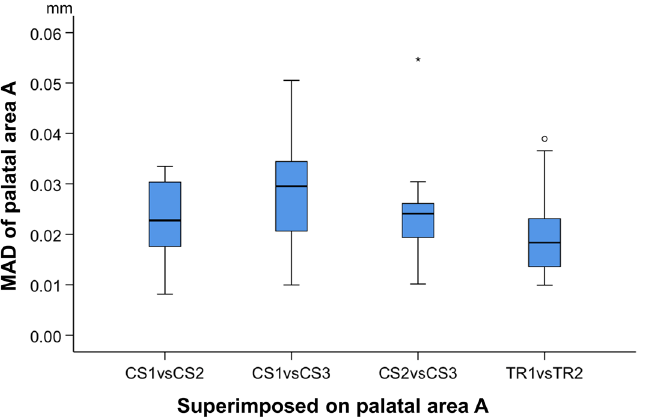
Figure 7. Box plots showing the precision of the two scanners (CS3600 and TRIOS3) measured through the MAD of palatal area A, between repeated scans superimposed on the same area (mm; Friedman test, p = 0.134). The upper limit of the black line represents the maximum value, the lower limit the minimum value, the box the interquartile range, and the horizontal line the median value. Outliers are shown as circles or stars, in more extreme cases. CS1, CS2, CS3: CS3600 repeated scans. TR1, TR2: TRIOS3 repeated scans.